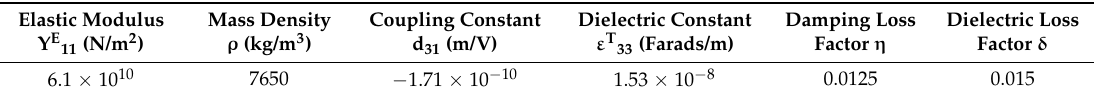
Table 3. Piezoelectric properties of the PZT